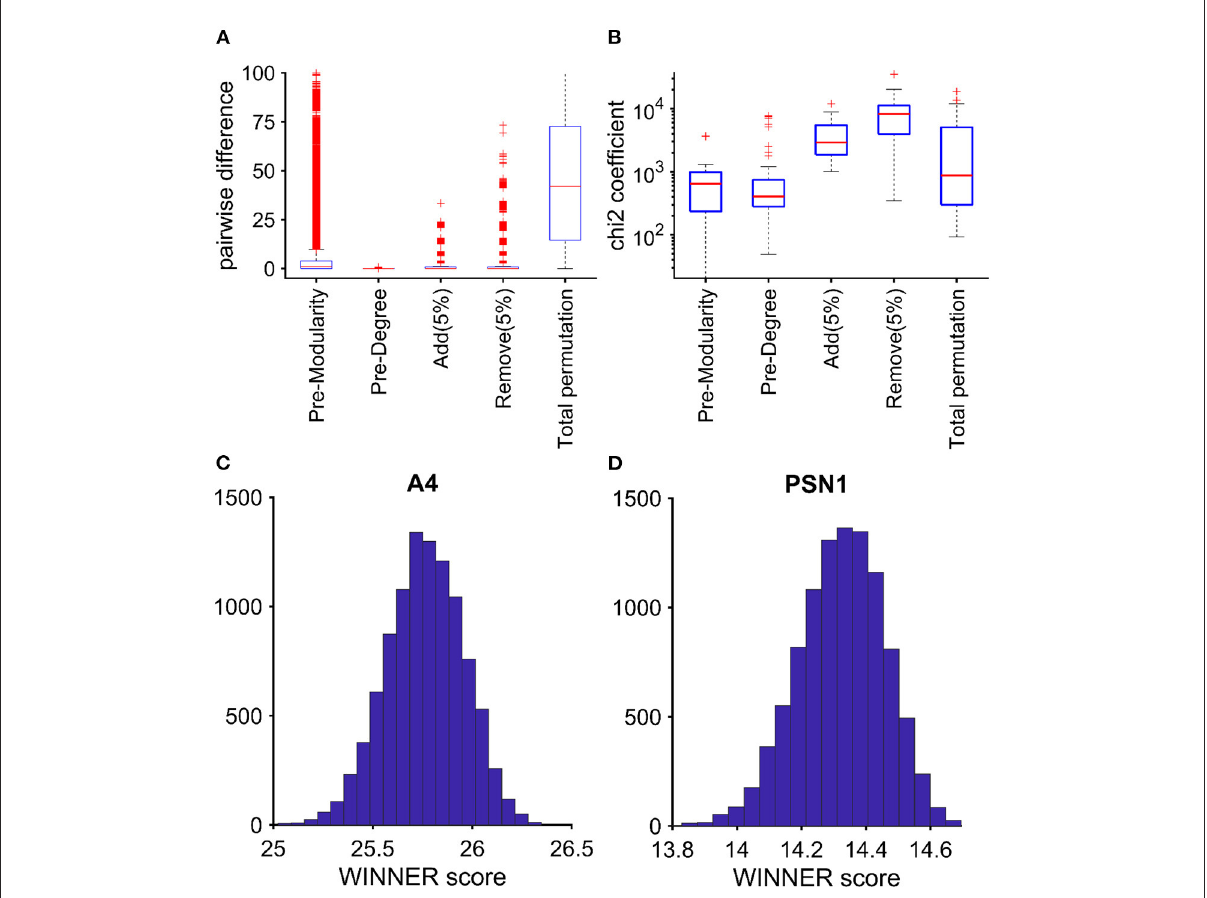
FIGURE2 With WINNER, Node-degree–preservation and modularity preservation yields more normally distributed randomized networks. Genes in the KEGG AD pathway were ranked via WINNER; then, the ranked networks were randomized via : preserving node degree (Pre-Degree), preserving modularity (Pre-Modularity), adding 5% interactions [Add (5%)], removing 5% of the interactions [Remove (5%)], and total network permutation. (A) The (pairwise) difference between the original network ranking score and the random network ranking score; smaller difference implies the random network approach is more likely to preserve the original network topology. (B) Chi-square (chi2coef) coefficient in chi2gof test (https:// www.mathworks.com/help/stats/chi2gof.html). Smaller chi2coef implies that the random ranking is more normally distributed. The ( the boxplots imply outliners (outside 2 and 98% percentiles). Under random network by preserving node degree, WINNER ranking